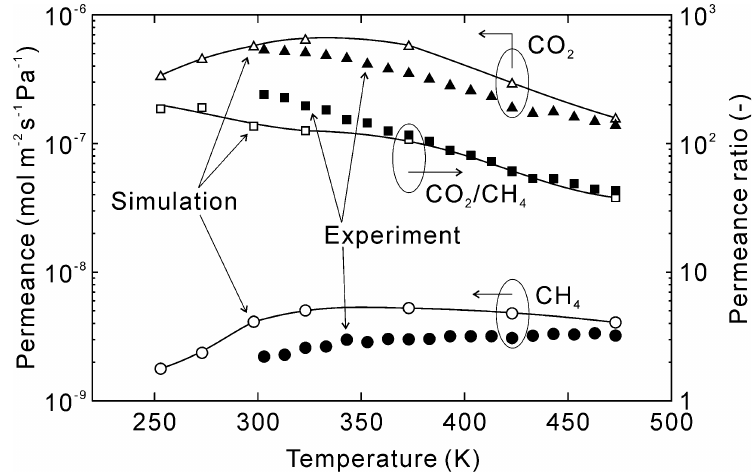
Figure 8. Effect of temperature on the permeation properties of the CHA-type zeolite membrane with Si/Al = 18.2. The permeation properties were calculated at CO 2 concentration = 50 vol% and total pressure = 300 kPa, experimental data were taken from [28].